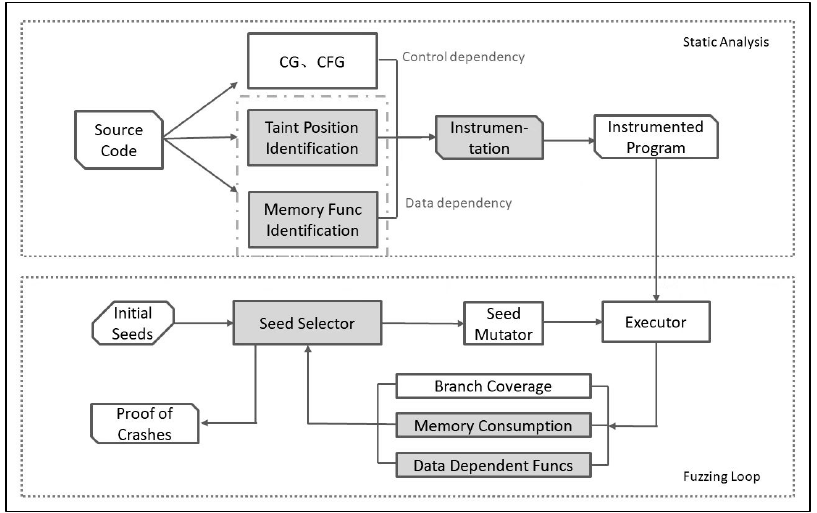
Figure 5. MemConFuzz